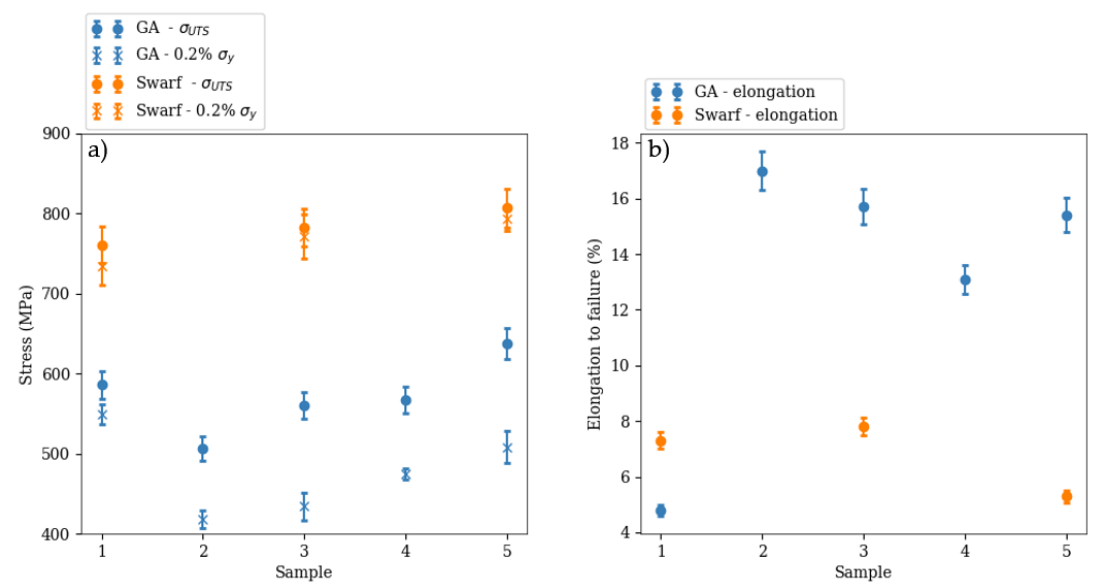
Figure 14. Room-temperature tensile mechanical properties, where ( a ) shows the yield strength and UTS, and ( b ) shows the elongation, for the as-extruded wire produced from the gas atomised and swarf titanium alloy feedstocks.